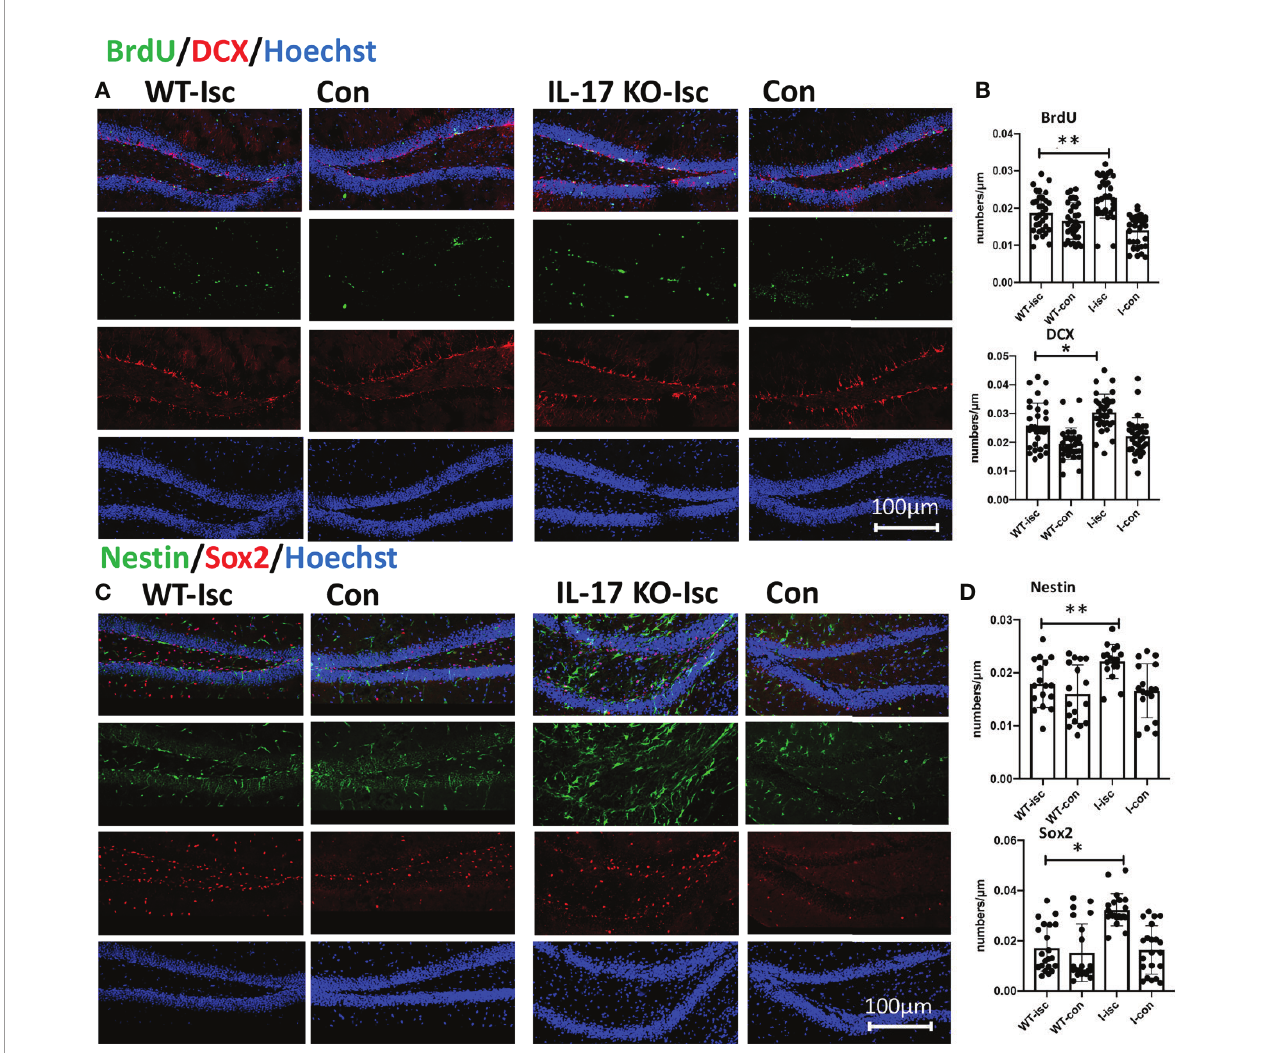
FIGURE 5 | IL-17 KO contributes to promoting neurogenesis and activating stemness of hippocampal NSCs after stroke. (A, C) Double-immunostaining for BrdU/ DCX and Nestin/Sox2 in the hippocampal DG of WT and IL-17 KO mice. (B, D) Notice signi fi cantly increased numbers of Nestin-, Sox2-, DCX-, and BrdU-positive cells in IL-17 KO mice compared with WT mice, respectively. n = 7, *p < 0.05, **p < 0.01. Isc, ischemic hippocampus; Con, contralateral hippocampus; WT, wild type; IL, interleukin; KO, knockout; I-isc, ischemic hippocampus of IL-17 KO mice; I-con, contralateral hippocampus of IL-17 KO mice; DCX, doublecortin; DG, dentate